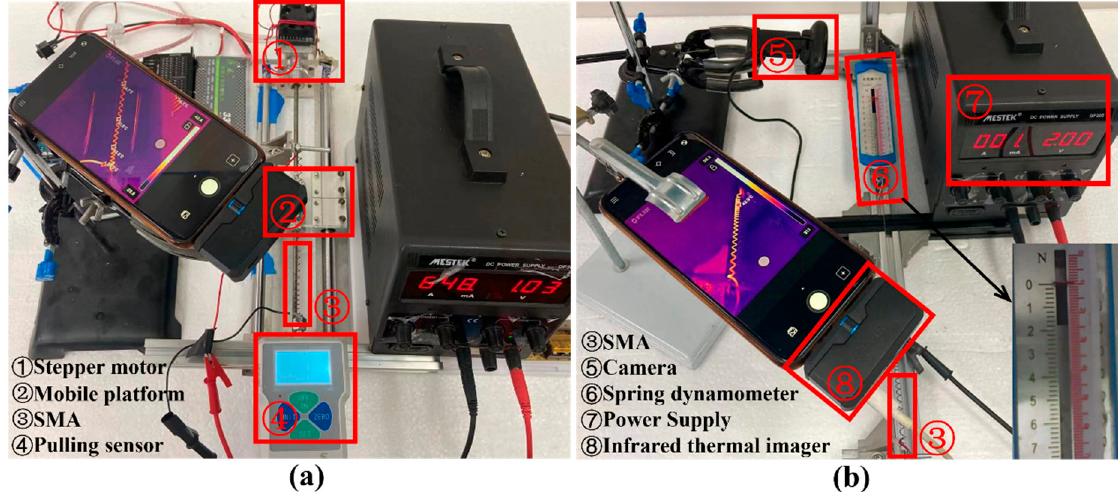
Figure 12. One-way SMA test platforms. ( a ) One-way SMA passive tensile test platform. ( b ) One-way SMA active shrinkage test platform.